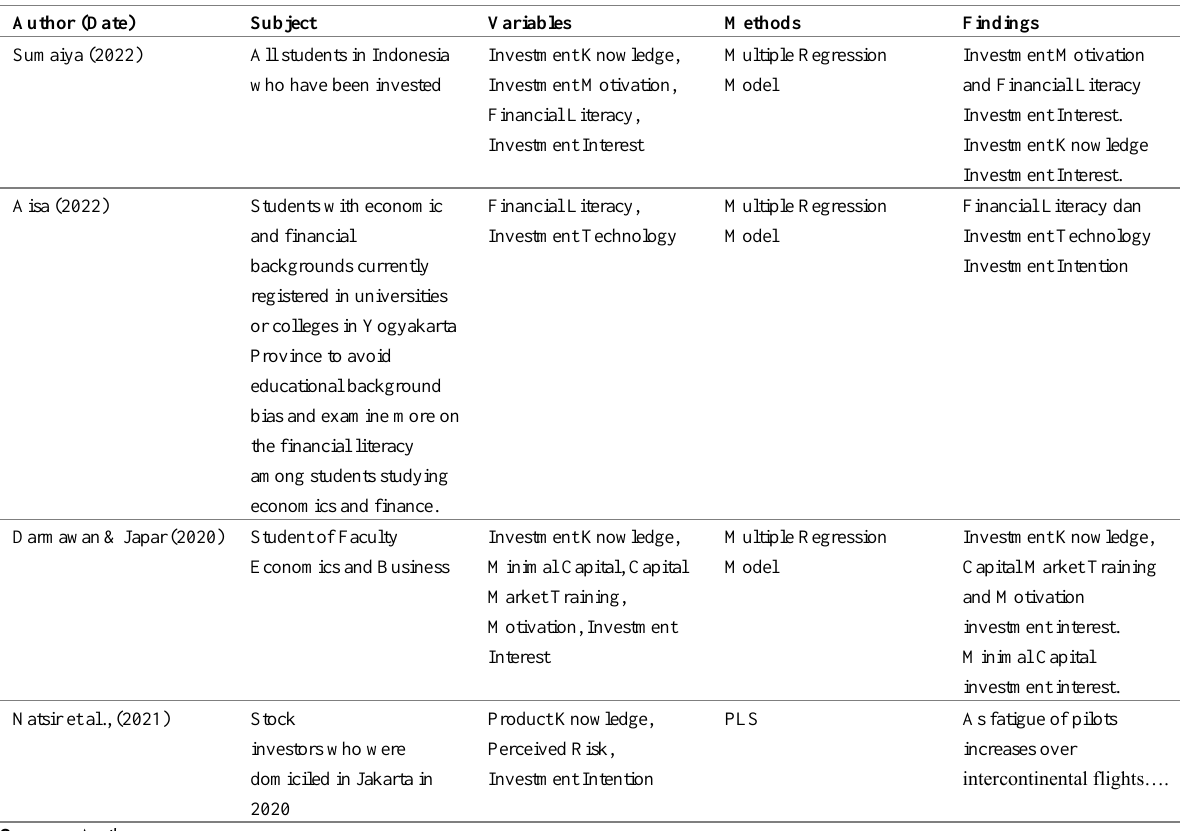
Table 1: Summary of Literature